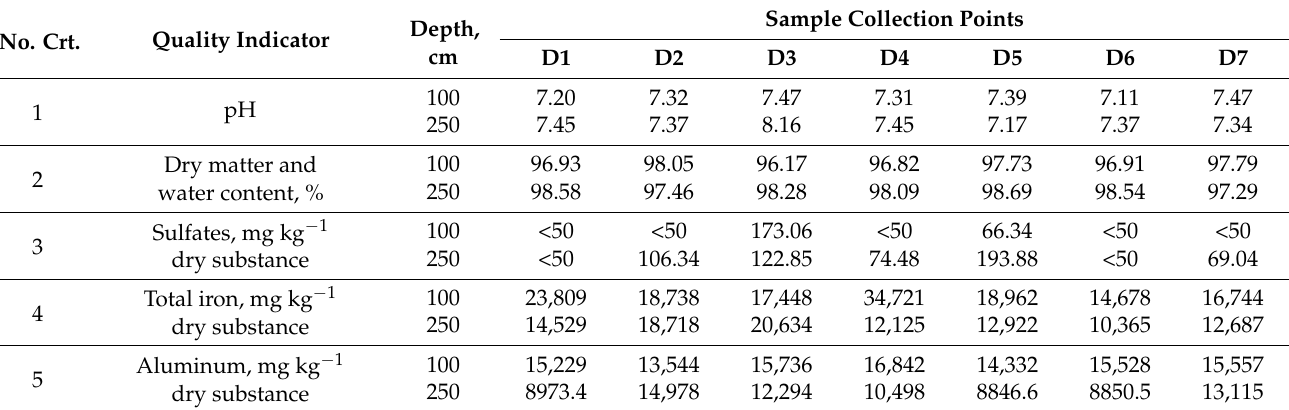
Table 4. The influence of the C0 sludge dump on the samples collected from the dump dam.